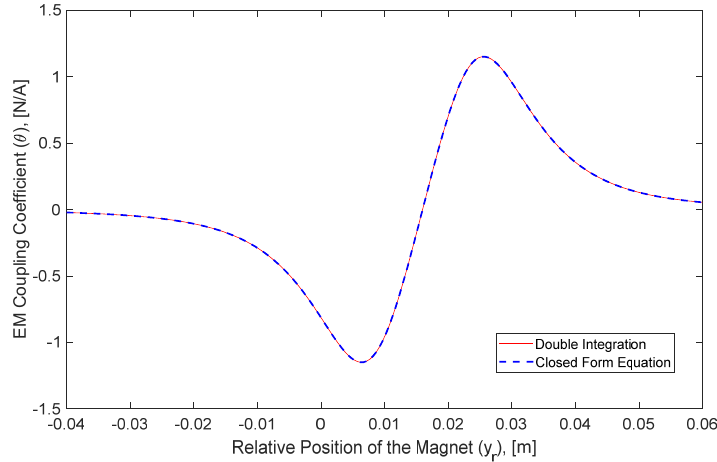
Figure 5. Magnet relative position versus EM coupling factor ( 𝜃 ) using double integration and its closed form given by Equation (11).